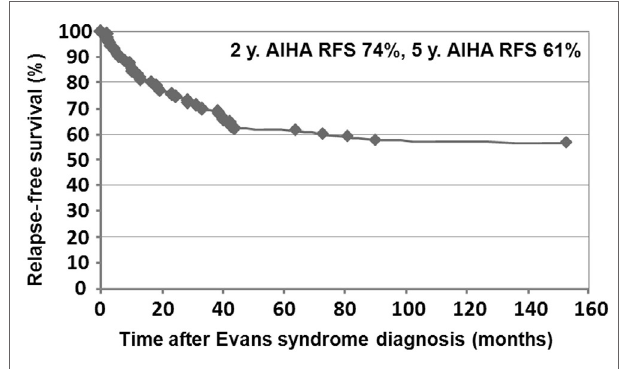
FigUre 3 | Kaplan–Meier aiha relapse-free survival in 90 children .